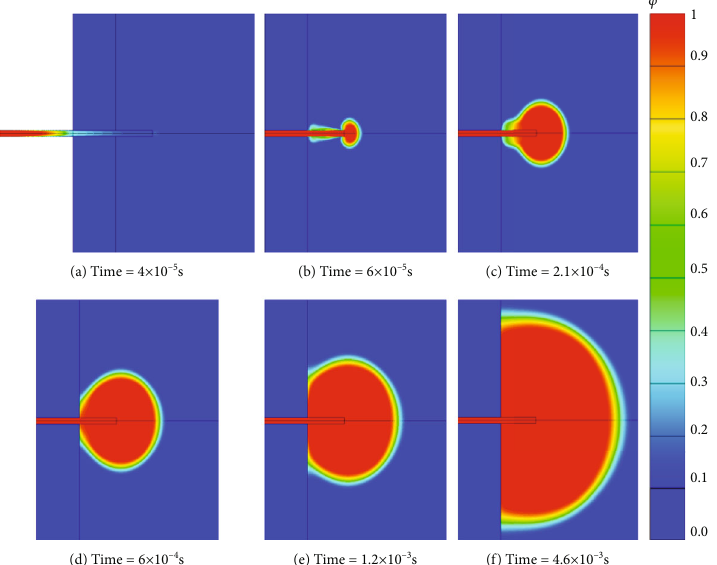
Figure 2: Changes of drug volume fraction in the subcutaneous tissue. (a) Time = 4 × 10 − 5 s . (b) Time = 6 × 10 − 5 s . (c) Time = 2 : 1 × 10 − 4 s . (d) Time = 6 × 10 − 4 s . (e) Time = 1 : 2 × 10 − 3 s . (f) Time = 4 : 6 × 10 − 3 s .